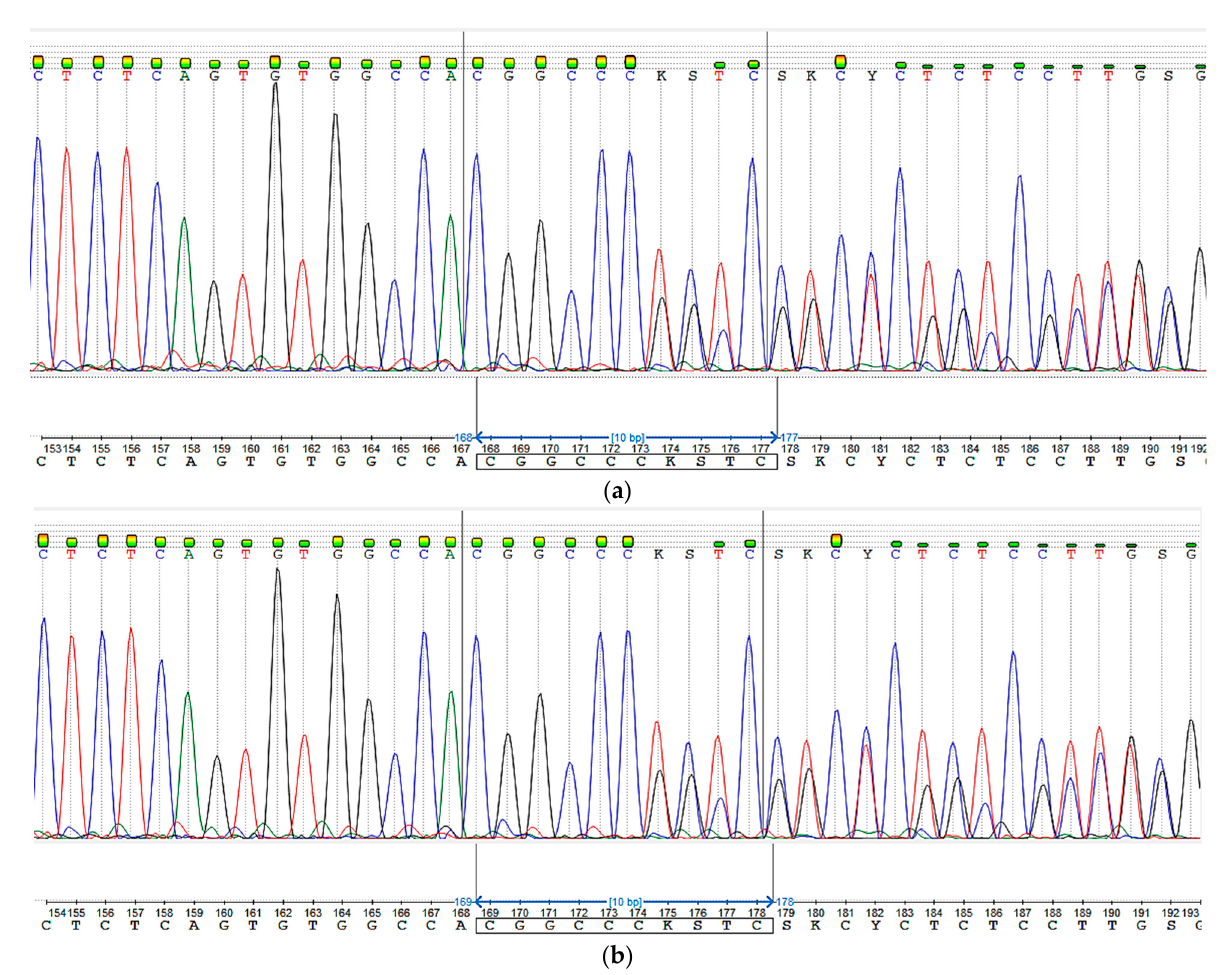
Figure 2. Patient Sanger sequencing. The duplication of five nucleotides–CGGCC. Sanger sequencing confirmed the chr17:1,770,026A>ACGGCC mutation in the pa- tient’s parents (Figure 3). Both parents were found to be heterozygous for the mutation c.259_260insCGGCC.